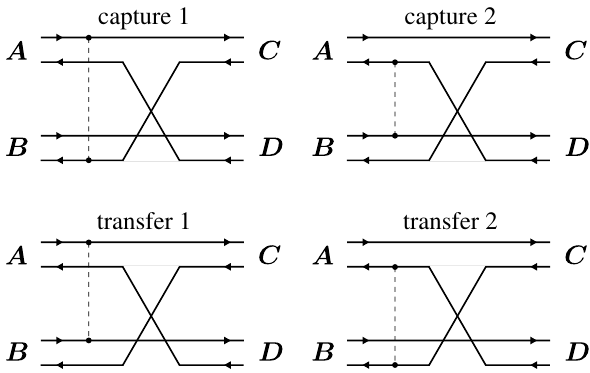
Figure 1. Quark exchange diagrams for “captures” 1,2 and “transfers” 1,2 in the meson-meson scat- tering AB →